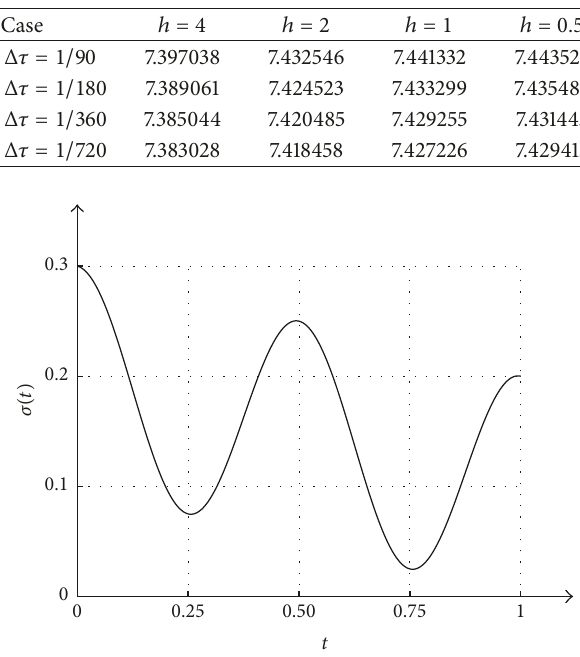
Figure 3: Volatility function, 𝜎(𝑡) = 0.1 cos (4𝜋𝑡) − 0.1𝑡 + 0.2